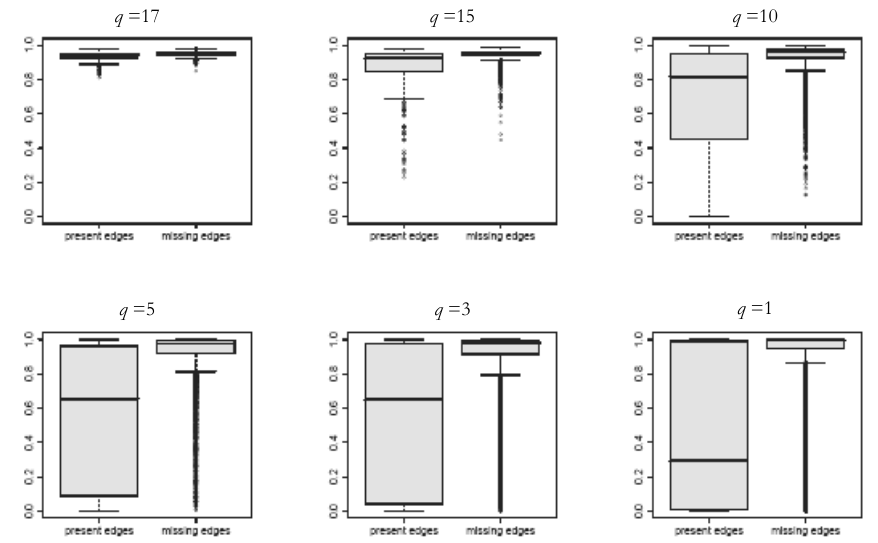
Figure 7 – Distribution of the non-rejection rate for present and missing edges of G 1 = ( V , E 1 ), to be associated with the corresponding histograms in figure 6. is only 38.32%, all the other considered values of q provide satisfying